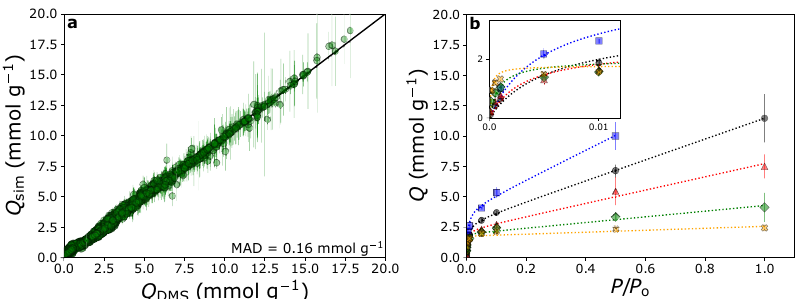
Fig. 2 Demonstration of the applicability of the dual-mode sorption (DMS) model fi t. a Parity plot comparing the DMS isotherm model to the full set of simulated adsorption loading data, where the mean absolute deviation (MAD) is calculated to be 0.16 mmol g − 1 . b Example DMS model fi ts (dotted lines) to simulated adsorption state points for propene (black circles), acetaldehyde (blue squares), butane (red triangles), n- hexane (green diamonds), and dipropyl ether (orange crosses) in carboxyPIM-1. Error bars indicate 95% con fi dence intervals (1.96 standard deviations) from simulations of independent